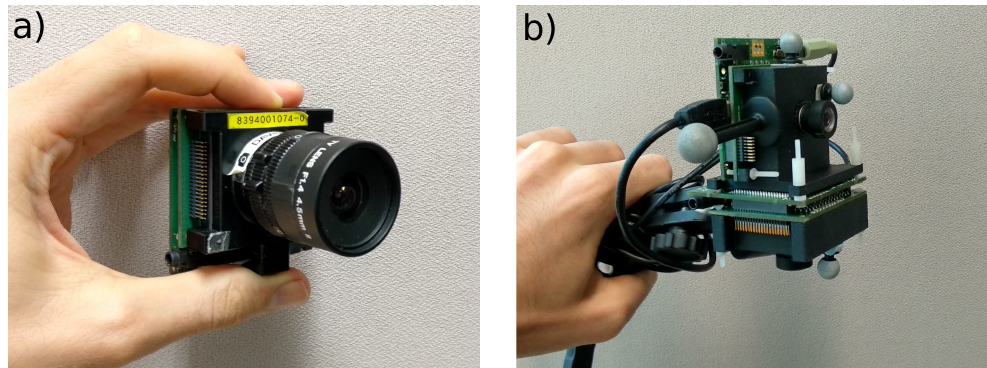
Figure 4. The two different sensor setups. ( a ) DAVIS240C sensor with a 4.5 mm lens used for the monocular experiments. ( b ) The dual sensor rig mounted on a tripod. Both sensors are equipped with low distortion 3.6 mm lenses, thanks to 3D printed mounts.